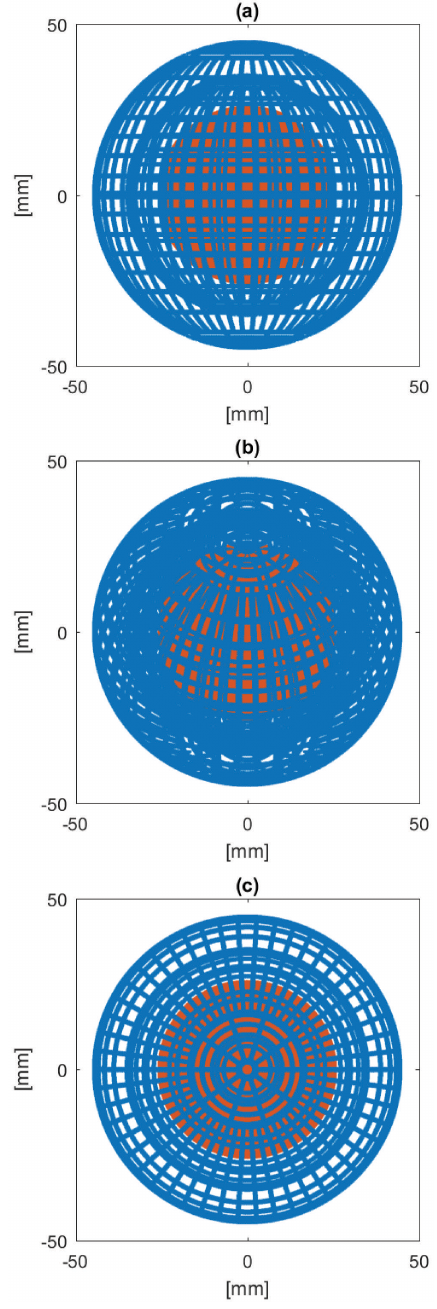
Figure 7. Illumination on the MSPD for an inclination angle of (a) 0 ◦ , (b) 45 ◦ and (c) 90 ◦ . Red shows the rays hitting the central electrode and blue represents the rays hitting the